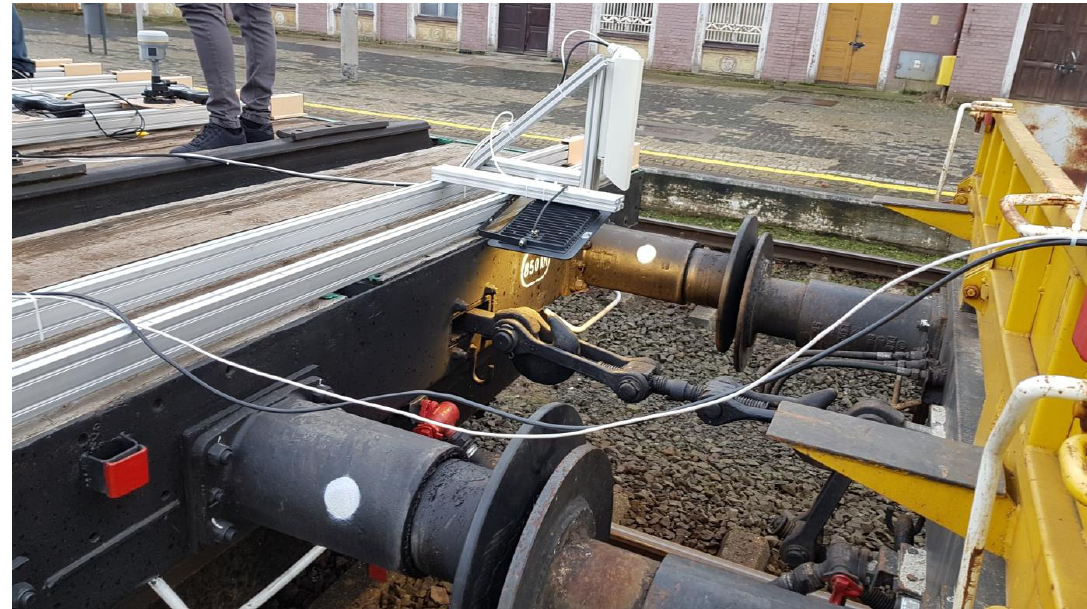
Figure 19. The coupling connecting the power car with the platform car.